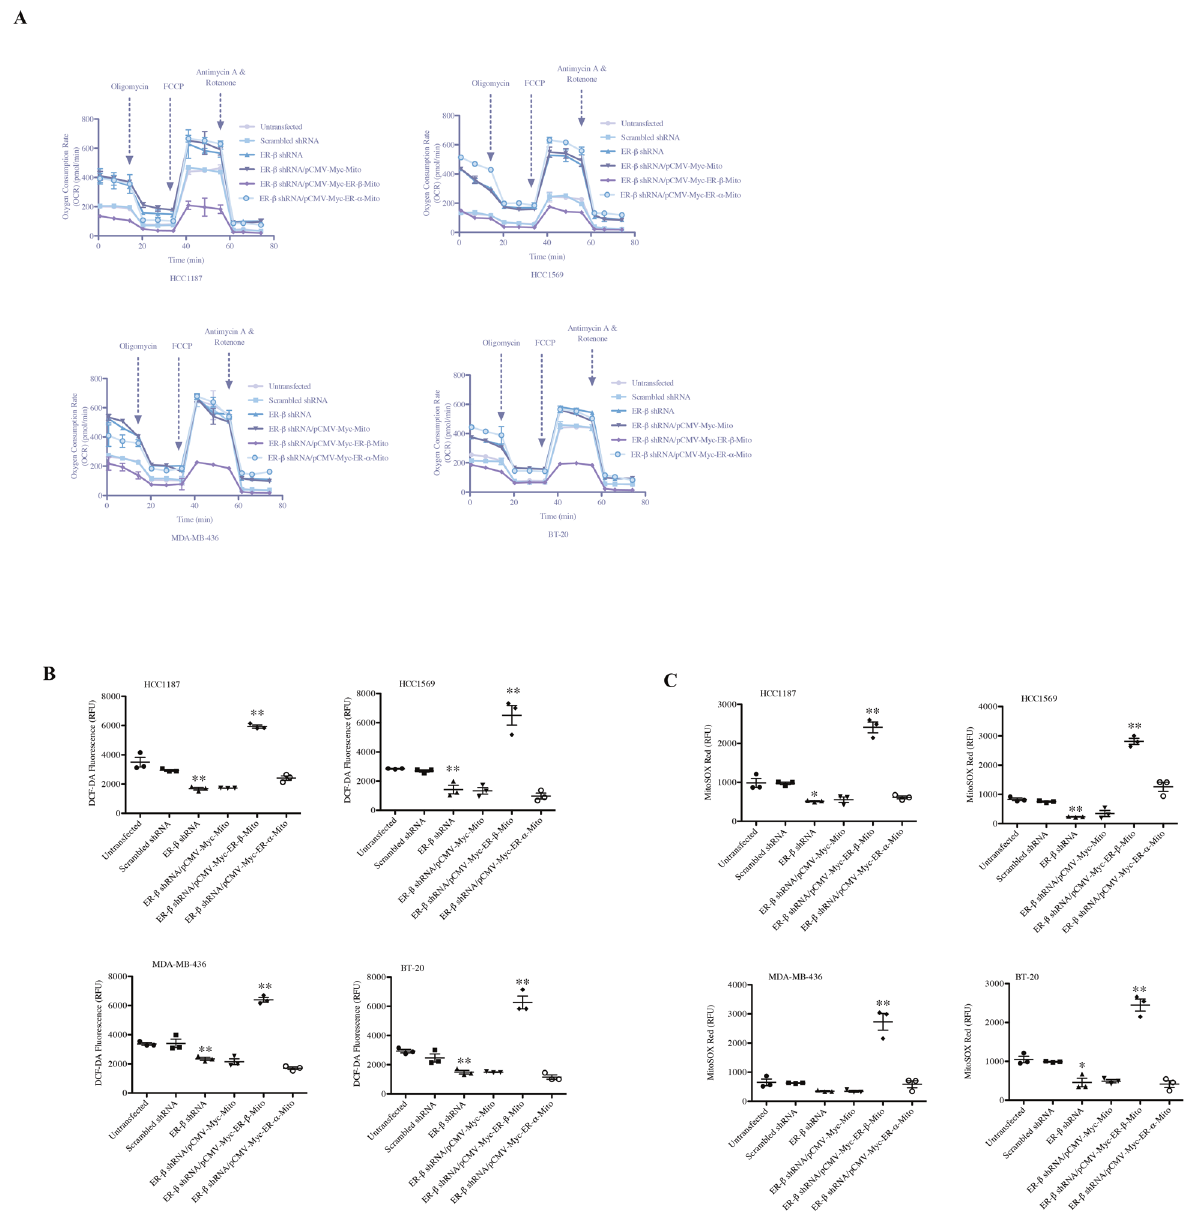
Fig. 6 Mitochondrial ER- β and ER- α differentially regulate mitochondrial respiration and ROS production. A OCRs (oxygen consumption rates) were determined in untransfected, scrambled shRNA-transfected, ER- β shRNA-transfected, ER- β shRNA plus pCMV-Myc-Mito-transfected, ER- β shRNA plus pCMV-Myc-ER- β -Mito-transfected and ER- β shRNA plus pCMV-Myc-ER- α -Mito-transfected HCC1187, HCC1569, MDA-MB-436, and BT-20 cells. Data were shown as pmol/min. B Total ROS production and C mitochondrial superoxide production were measured in untransfected, scrambled shRNA-transfected, ER- β shRNA-transfected, ER- β shRNA plus pCMV-Myc-Mito-transfected, ER- β shRNA plus pCMV- Myc-ER- β -Mito-transfected and ER- β shRNA plus pCMV-Myc-ER- α -Mito-transfected HCC1187, HCC1569, MDA-MB-436, and BT-20 cells (mean ± SEM, n = 3; * P < 0.05, ** P < 0.01 by two-tailed Student ’ s t test, Untransfected vs. ER- β shRNA, ER- β shRNA vs. ER- β shRNA/pCMV-Myc-ER- β